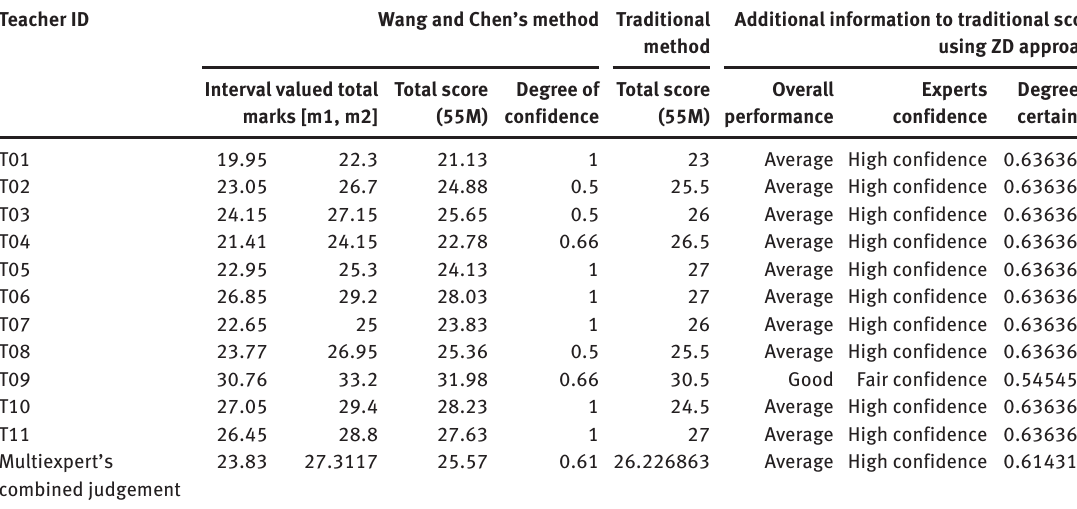
Table 10: Comparison of the Evaluating Results of Student ID-02’s Answer Script Using the Wang and Chen Method with ZD